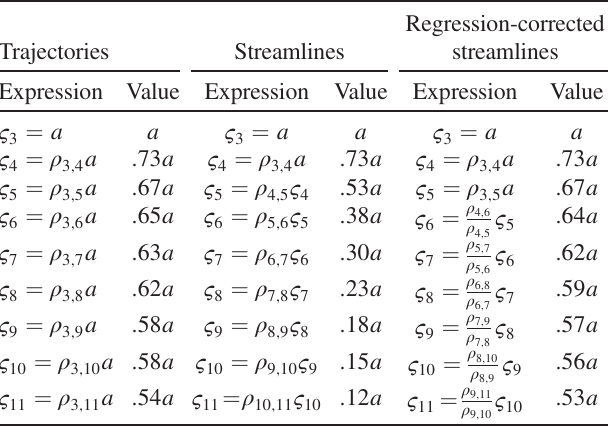
TABLE III. Comparison between the theoretical score sequen- ces within the trajectory, cohort streamline, and RC cohort streamline frameworks, using the Pearson correlation coefficients computed from the data for the cohort of